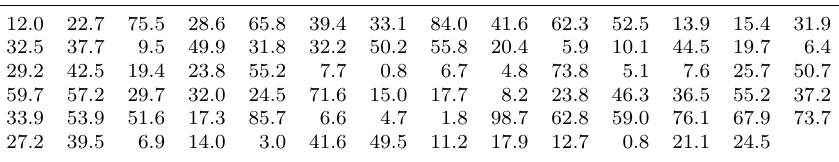
Table 5. Carrol data set ( n =